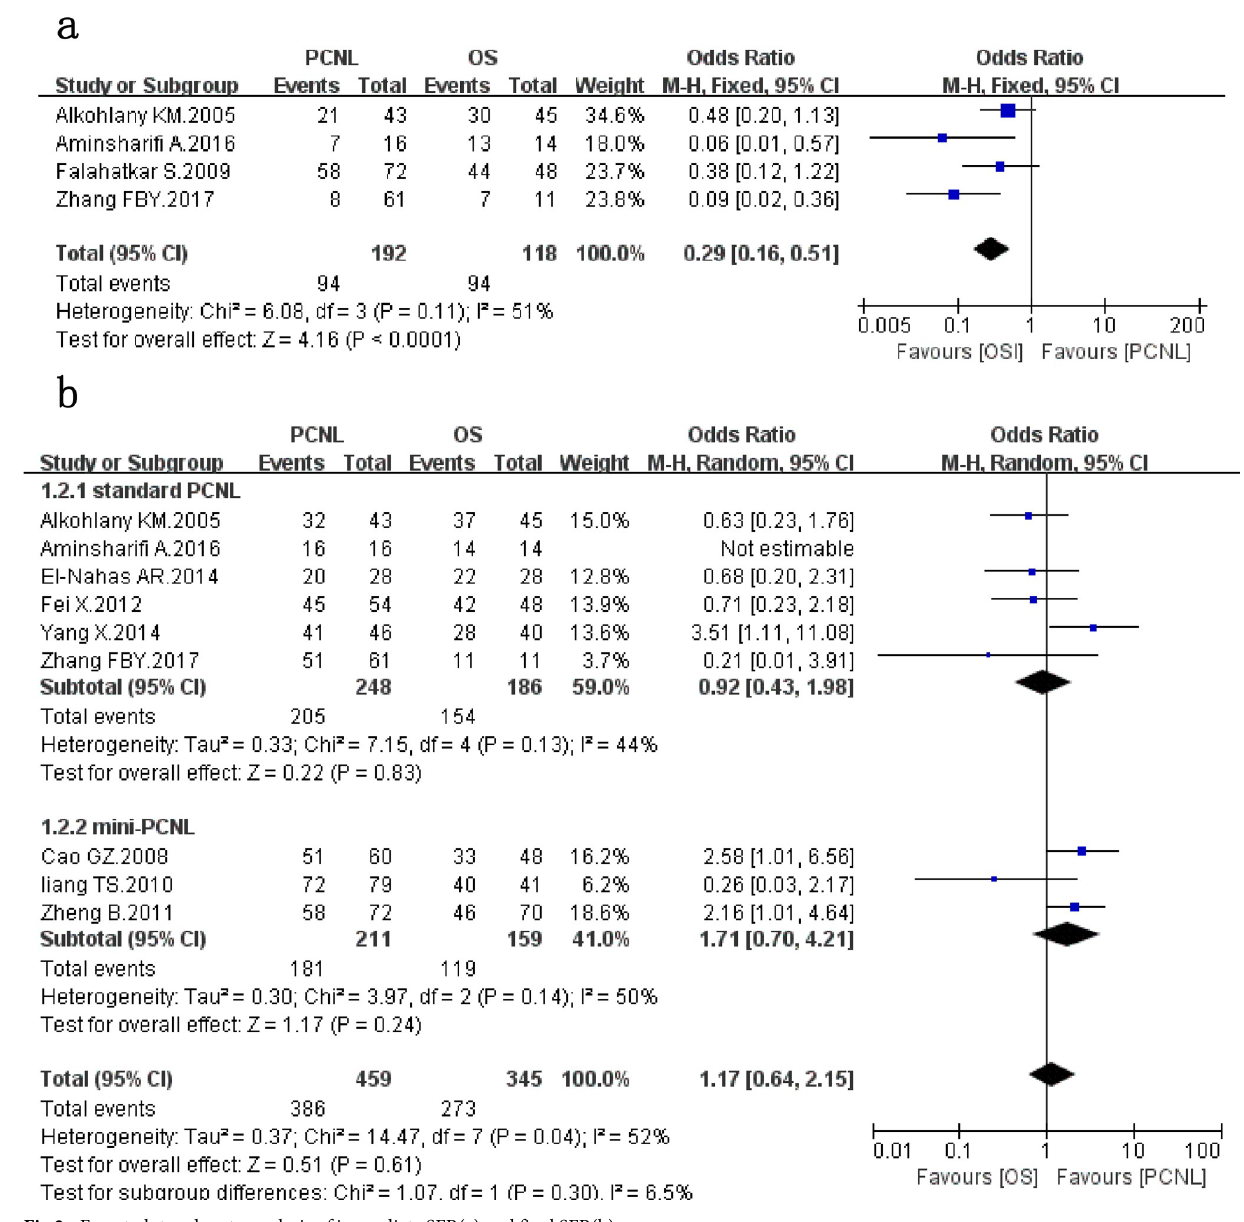
Fig 2. Forest plot and meta-analysis of immediate SFR(a) and final SFR(b). https://doi.org/10.1371/journal.pone.0206810.g002 Data on final SFR were available in 9 studies[6–14], which evaluated 804 patients(Fig